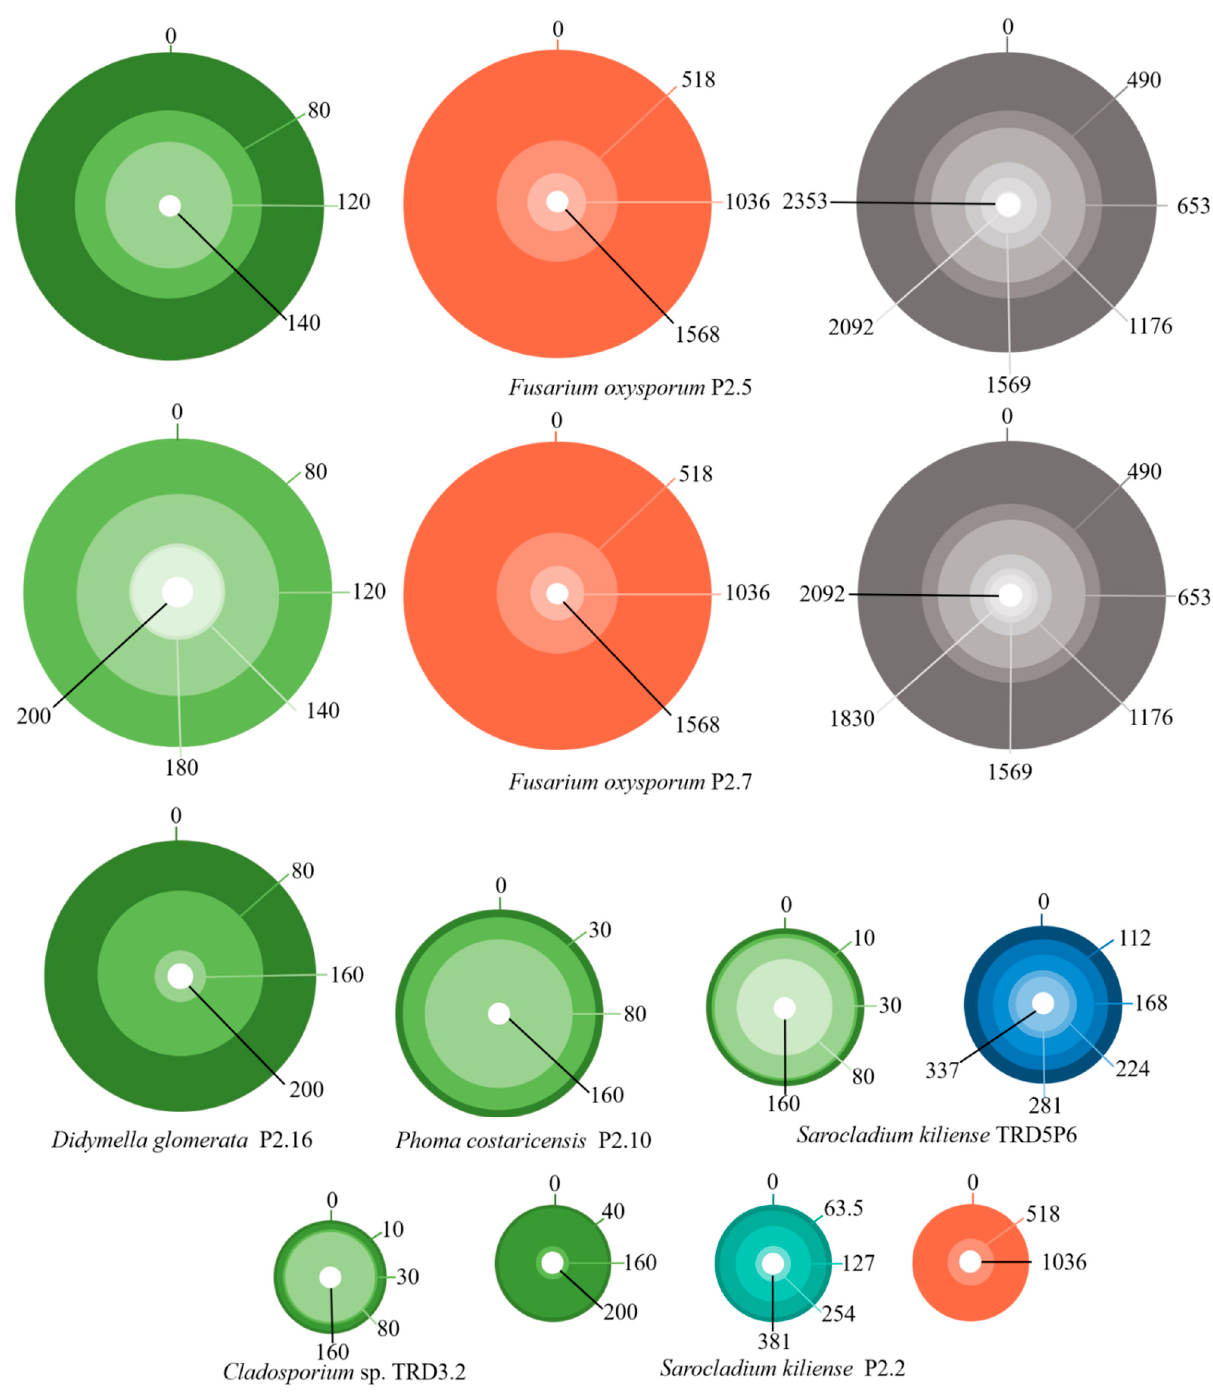
Figure 5. Representation of the minimum inhibitory concentration assay (mg/L) for investigated fungal species: Hg 2+ (green), Pb 2+ (red), Zn 2+ (gray), Cd 2+ (dark blue), Cu 2+ (turquoise).